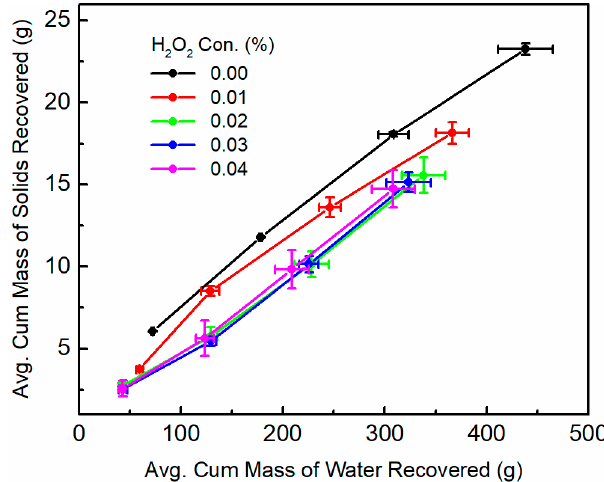
Figure 3. Average cumulative mass of solids versus water at different H 2 O 2 concentrations. Error bars represent the standard deviation between duplicate tests.